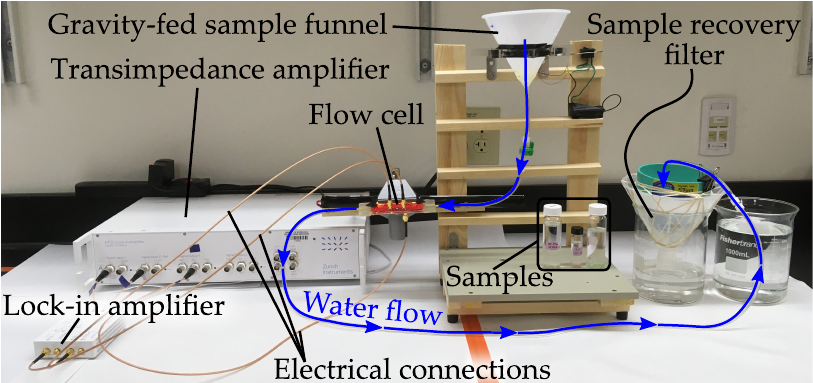
Figure 14. The test setup used in Colson and Michel (2021) to demonstrate impedance spectroscopy for quantification of MPs directly in a flow of water [35].